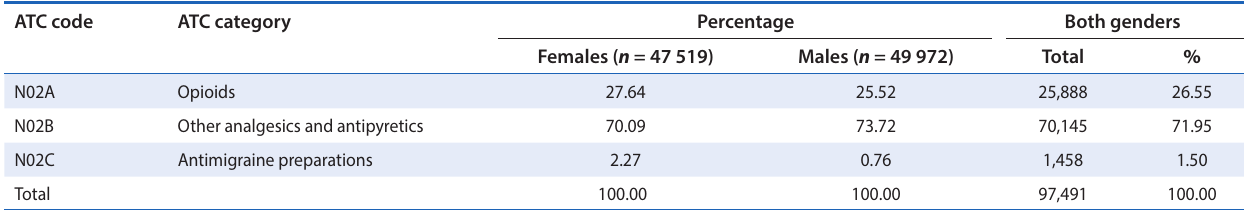
Table 1: Frequency of prescriptions in the different ATC analgesic categories ATC code